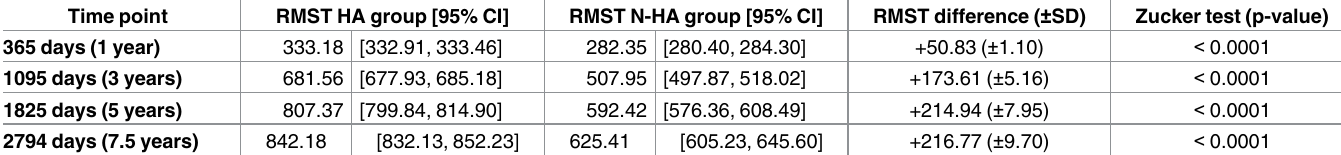
Table 3. Restrictedmean survival time estimatesfrom the stratified Cox Model.